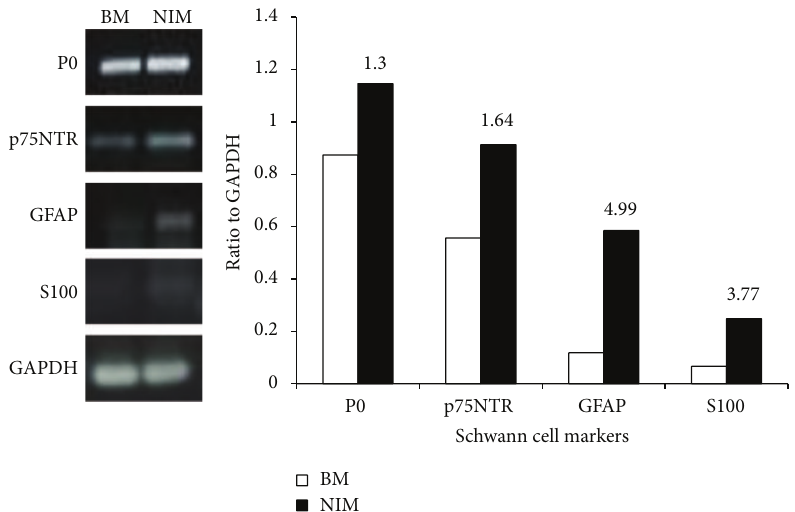
Figure 6: hADSCs can differentiate into Schwann cell phenotype. hADSCs were grown in BM and nerve induction medium (NIM) for 14 days. Using gene specific primers, mRNA expression of Schwann cell markers P0, p75NTR, GFAP, and S100 was determined from the cDNA templates. The PCR mixture was separated into a 1% agarose gel and the bands were visualized by ethidium bromide staining of the gels. The band intensities were quantified using ImageJ